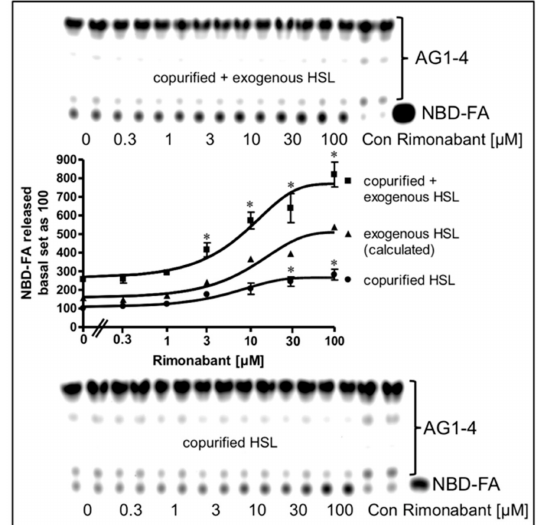
Figure 10. Stimulation of lipolysis in a cell-free system from Rimonabant-treated rat adipocytes. Primary rat adipocytes, which had been metabolically labelled with NBD-FA, were incubated (20 min, 37 ◦ C) in the absence or presence of increasing concentrations of Rimonabant. Subsequently, LD were prepared from the washed adipocytes, reconstituted without (copurified HSL) or with partially purified rat adipocyte HSL (copurified + exogenous HSL)(see Materials and Methods) and then incubated (90 min, 30 ◦ C). The organic phase of the chloroform / methanol / HCl-extract of the total incubation mixture was analyzed by TLC. The amount of NBD-FA lipolytically released from the NBD-FA-labelled AG1–4 and run in parallel to a synthetic NBD-FA marker (ma) was quantitatively evaluated by fluorescence imaging. Fluorogram of a typical experiment with TLC runs (only 1 / 5 of the volumes obtained from the total incubation mixtures of the “copurified + exogenous HSL” reactions were applied) in duplicate repeated two times; quantitative evaluation (mean ± SD) of the three di ff erent incubations with TLC analysis (corrected for the di ff erent volumes applied) in duplicate with • calculated as di ff erence (exogenous HSL) of the reaction containing and lacking exogenously added HSL. A blank value from a control reaction terminated immediately after the addition of HSL (copurified + exogenous HSL) or bu ff er (copurified HSL) was subtracted in each case. NBD-FA released in the absence of Rimonabant (basal) was set at 100 for each reaction containing or lacking exogenously added HSL. * p ≤ 0.05 for LD incubated with copurified plus exogenous HSL or copurified HSL alone between absence and presence of